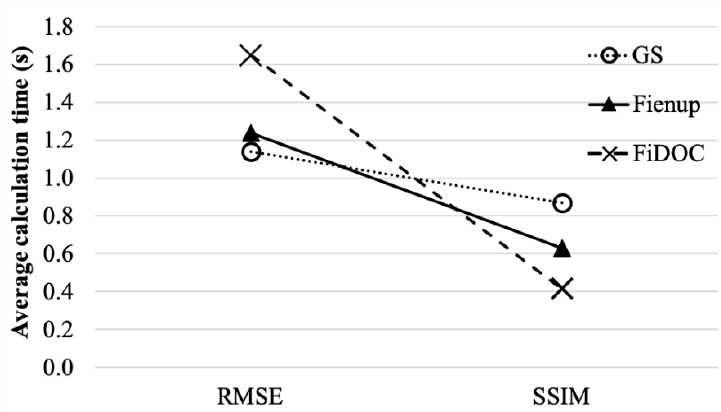
Figure 13. The average calculation time required for GS, Fienup and FiDOC algorithms based on RMSE and SSIM.